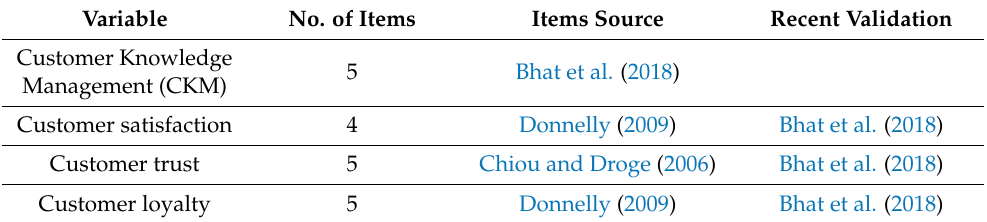
Table 1. Variables, number of items, and recent validation sources.